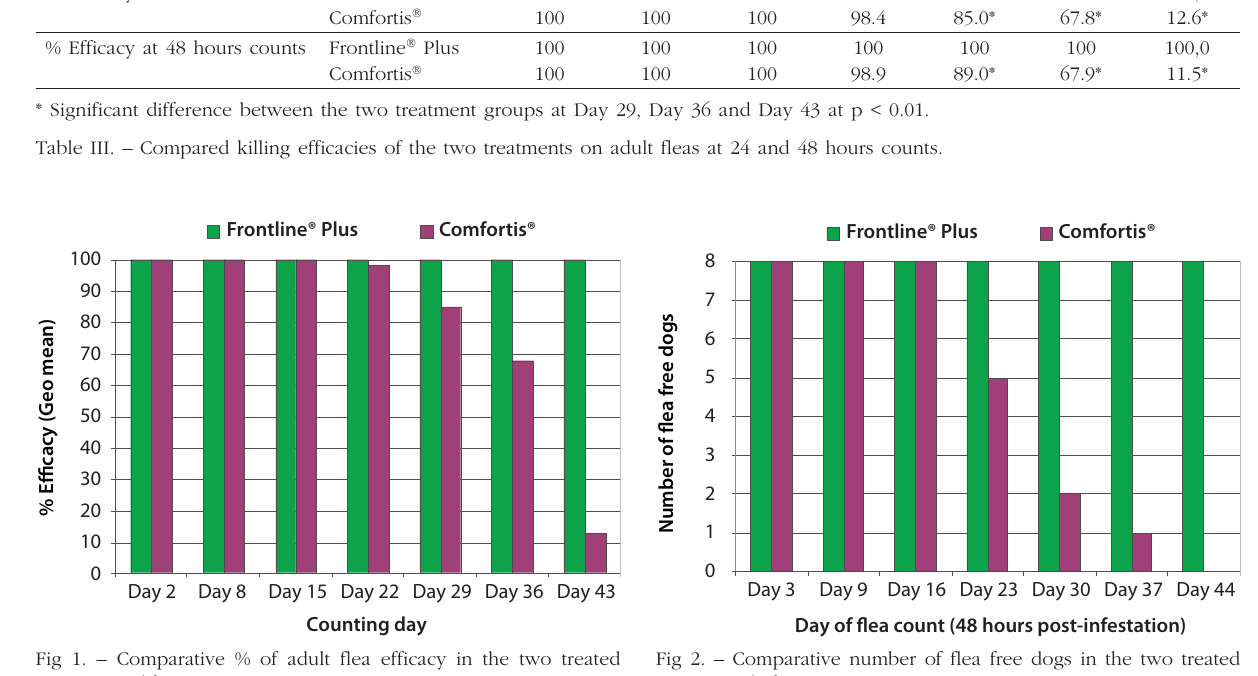
Fig 2. – Comparative number of flea free dogs in the two treated groups at 48 hours